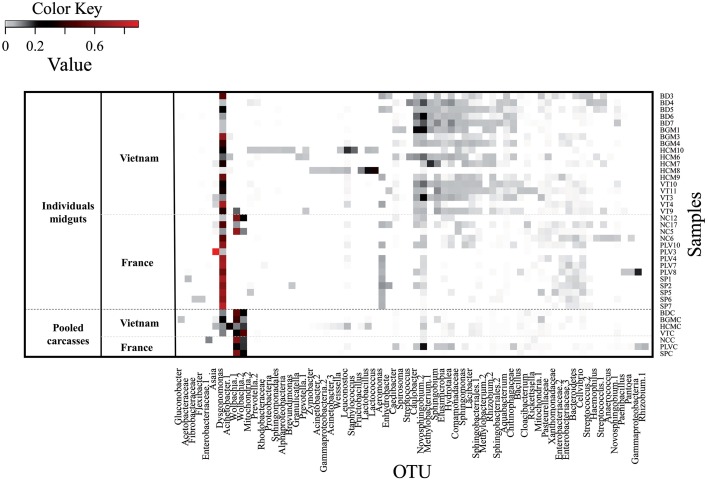
Aedes albopictus microbiota bacterial diversity. The heatmap represents the relative abundance of 3% OTUs in each sample. The Color Key Value refers to the proportion of an OTU in a single sample. The OTUs were represented if their proportion was =0.01 in at least one sample. They were named by their taxonomic assignment according to Bayesian classification. When more than one OTU get the same assignation, they were differentiated with numbers. Samples are classified according to their own populations. Individual midgut samples from Vietnam were collected in Bình Du'o'ng (BD 3, 4, 5, 6, and 7), Bù Gia Mâp (BGM 1, 3, 4), Hồ Chí Minh City (HCM 6, 7, 8, 9, 10), Vung Tàu City (VT 3, 4, 9, 10, 11). Individual midgut samples from France were collected in Nice (NC 5, 6, 12, 17), Portes-Lès-Valence (PLV 3, 4, 7, 8, 10), and Saint Priest (SP 1, 2, 5, 6, 7). The pooled carcasses of the following individuals were also analyzed for both Vietnamese (BDC, BGMC, HCMC, VTC) and French populations (NCC, PLVC, SPC); the last “C” added to each name indicates carcass.